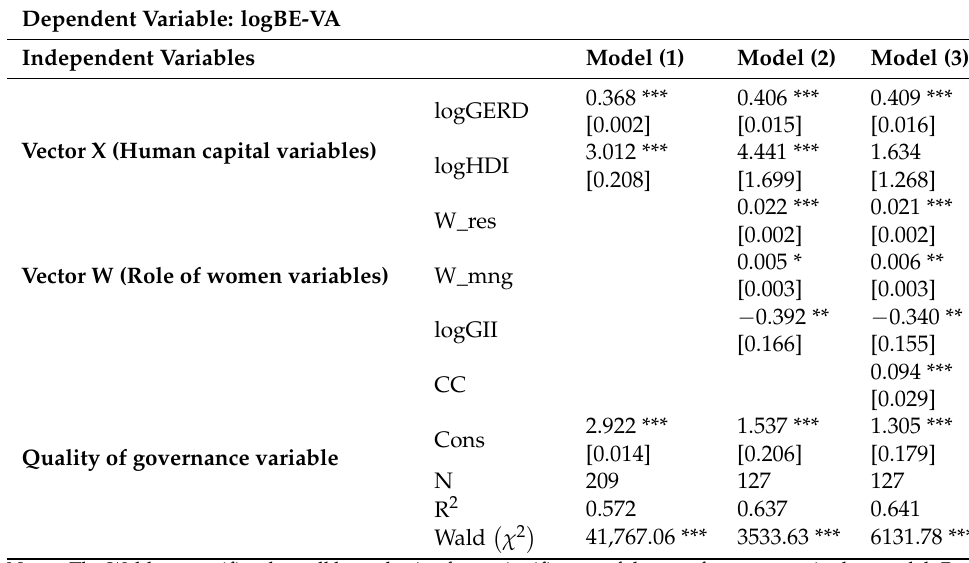
Table 2. Results from panel analysis estimated with